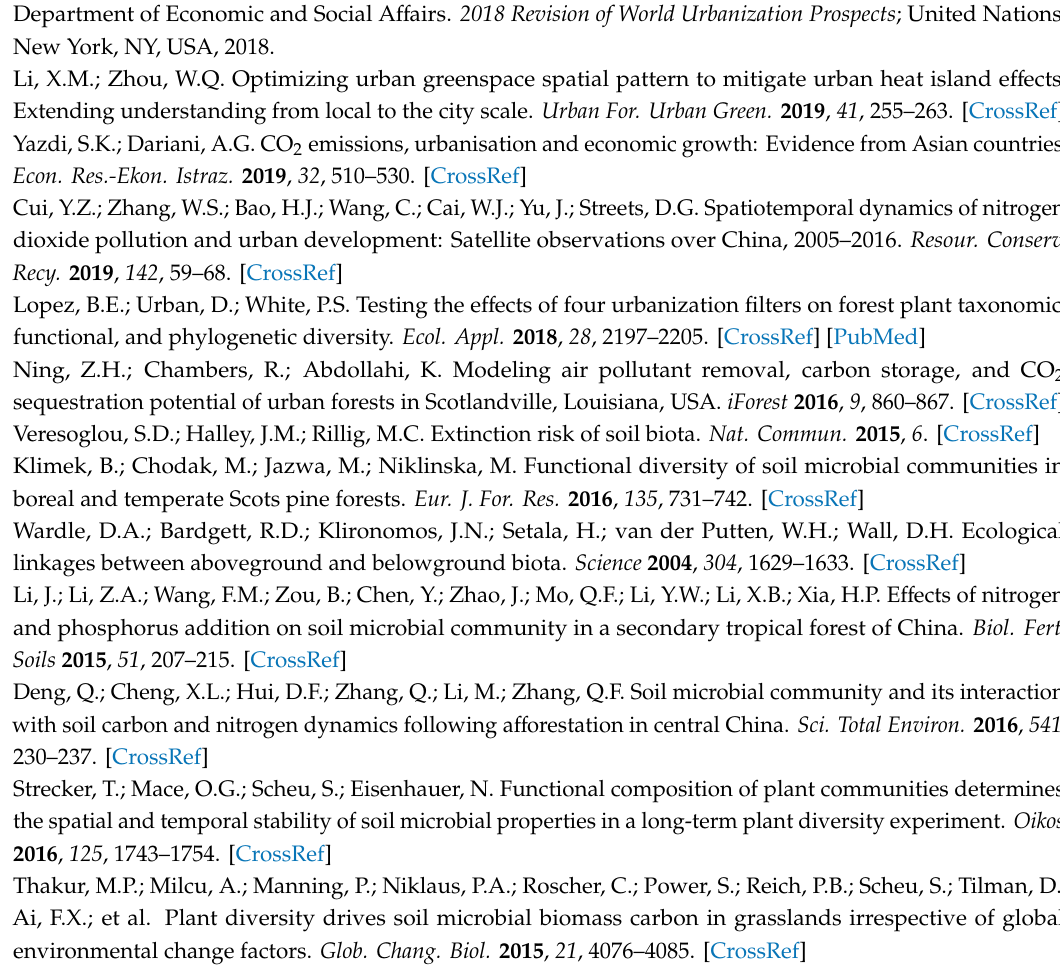
proportions of variation at phylum level in composition of soil bacterial community (A) and soil fungal community (B) composition explained by soil and plant variables, Table S1: Abbreviations and corresponding full names of plant traits and soil properties in this paper, Table S2: Relative abundance of bacterial composition along the urban-to-rural gradient at phylum and genus level, Table S3: Relative abundance of fungal composition along the urban-to-rural gradient at phylum and genus level, Table S4. The PerMANOVA analyses of bacterial and fungal OTUs along the urban-to-rural gradient, Table S5: The PerMANOVA analyses of bacterial and fungal functional groups along the urban-to-rural gradient; Table S6. Spearman correlation of bacterial and fungal functional groups with plant and soil variables, Table S7: Spearman correlation of bacterial composition with plant and soil variables at phylum level, Table S8: Spearman correlation of bacterial composition with plant and soil variables at genus level, Table S9: Spearman correlation of fungal composition with plant and soil properties at phylum level, Table S10: Spearman correlation of fungal composition with plant traits and soil properties at genus level, Table S11: The results of RDA monte carlo tests of soil bacterial and fungal community